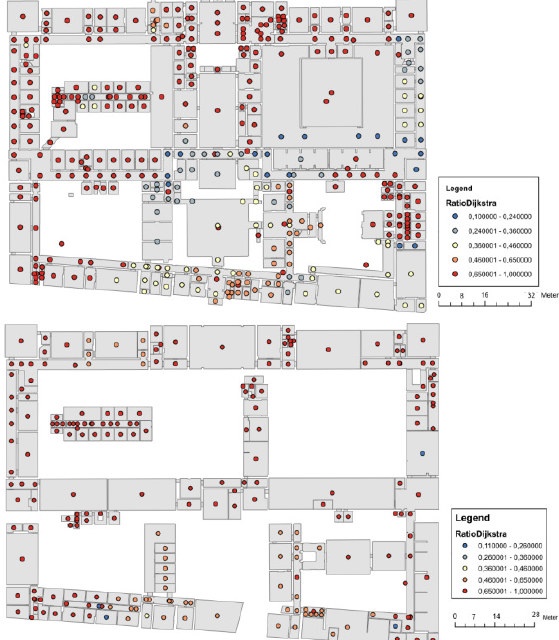
Figure 9: Jaccard index showing the path differences in usage of nodes (floor 0 (top) and 1